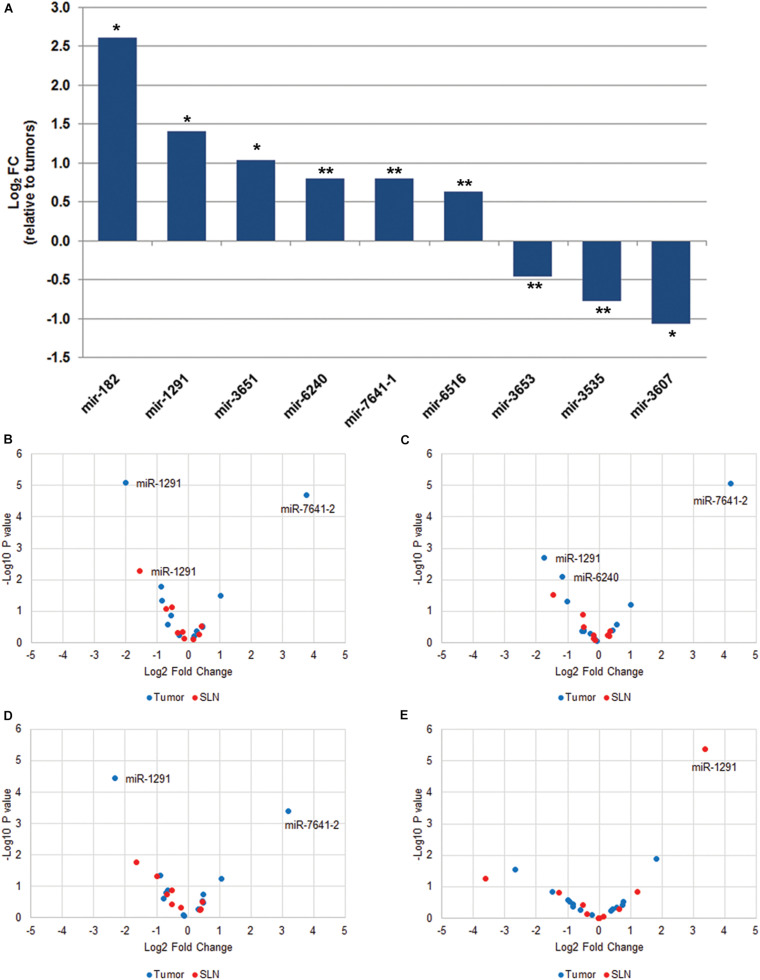
MiRNA expression profile in paired tumor and SLN samples from breast cancer patients. (A) Total number of miRNAs with significant differential expression (q < 0.05) in tumor samples compared to paired SLN samples. Data is expressed as log2 fold change relative to tumor samples. *q < 0.001, **q < 0.05. The volcano plots show differentially expressed miRNAs in tumor (blue) and SLN (red) samples according to the locoregional metastatic status: positive vs. negative (B), macrometastasis vs. negative (C), micrometastasis vs. negative (D), and subgroup of patients with macrometastasis that were treated with ALND and grouped according to the aLN status (positive vs. negative) (E). The data show the relationship between the p-values (y-axis) and the fold change (x-axis) between the experimental groups. Only miRNAs with q < 0.05 are shown in the plots.